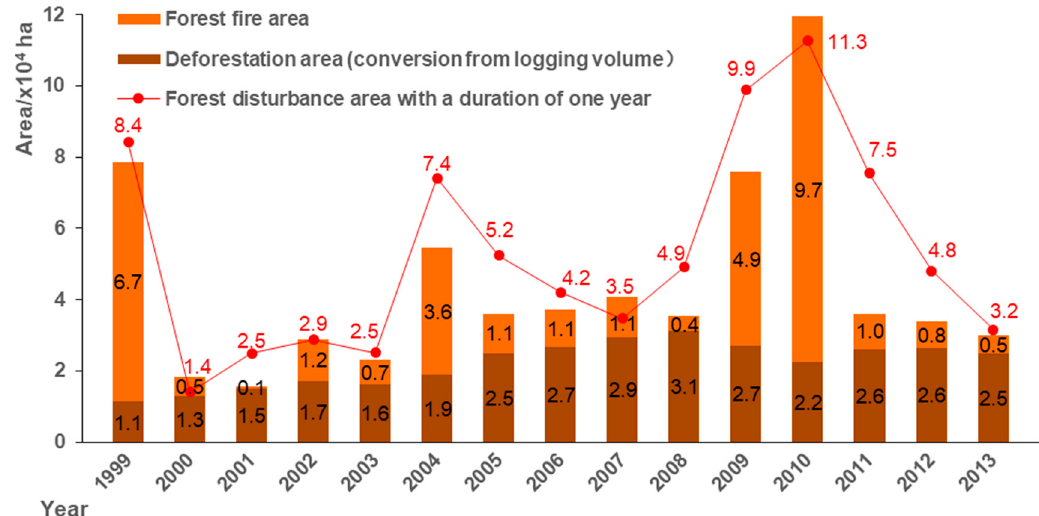
Figure 4. Forest disturbance and forest fires and logging in the study area from 1999 to 2013. The main causes of the forest disturbance areas with a duration of one year are deforestation and forest fires. In the figure, the remote sensing monitoring data of forest disturbance in the current year are compared with the forest fire and logging data of the previous year.